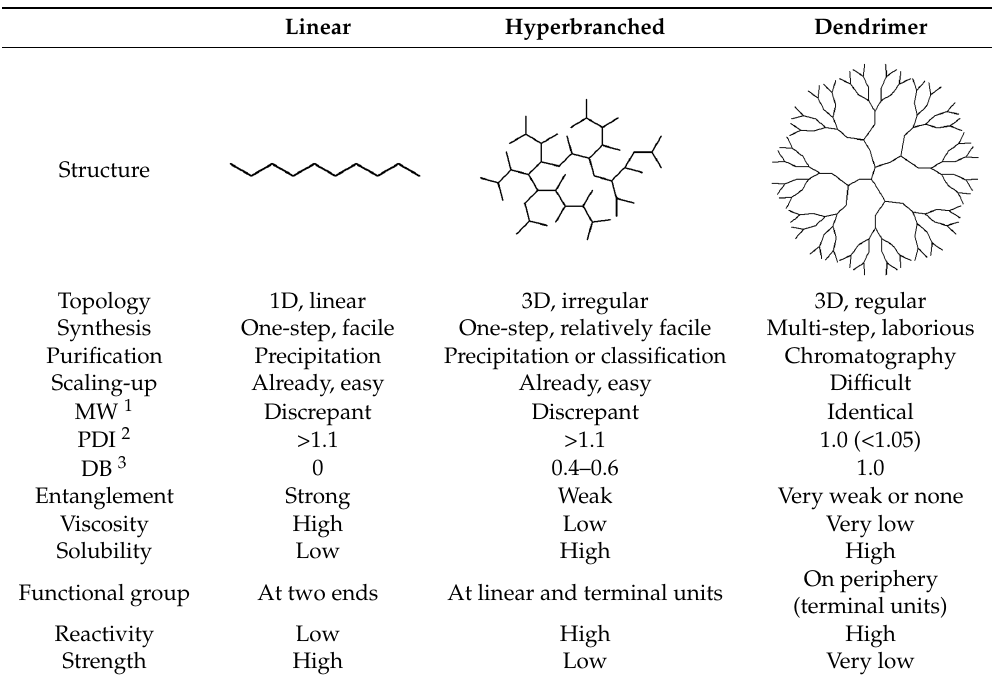
Table 1. Comparison of hyperbranched macromolecules with linear polymers and dendrimers. Reproduced from [7] with permission from the Royal Society of Chemistry.